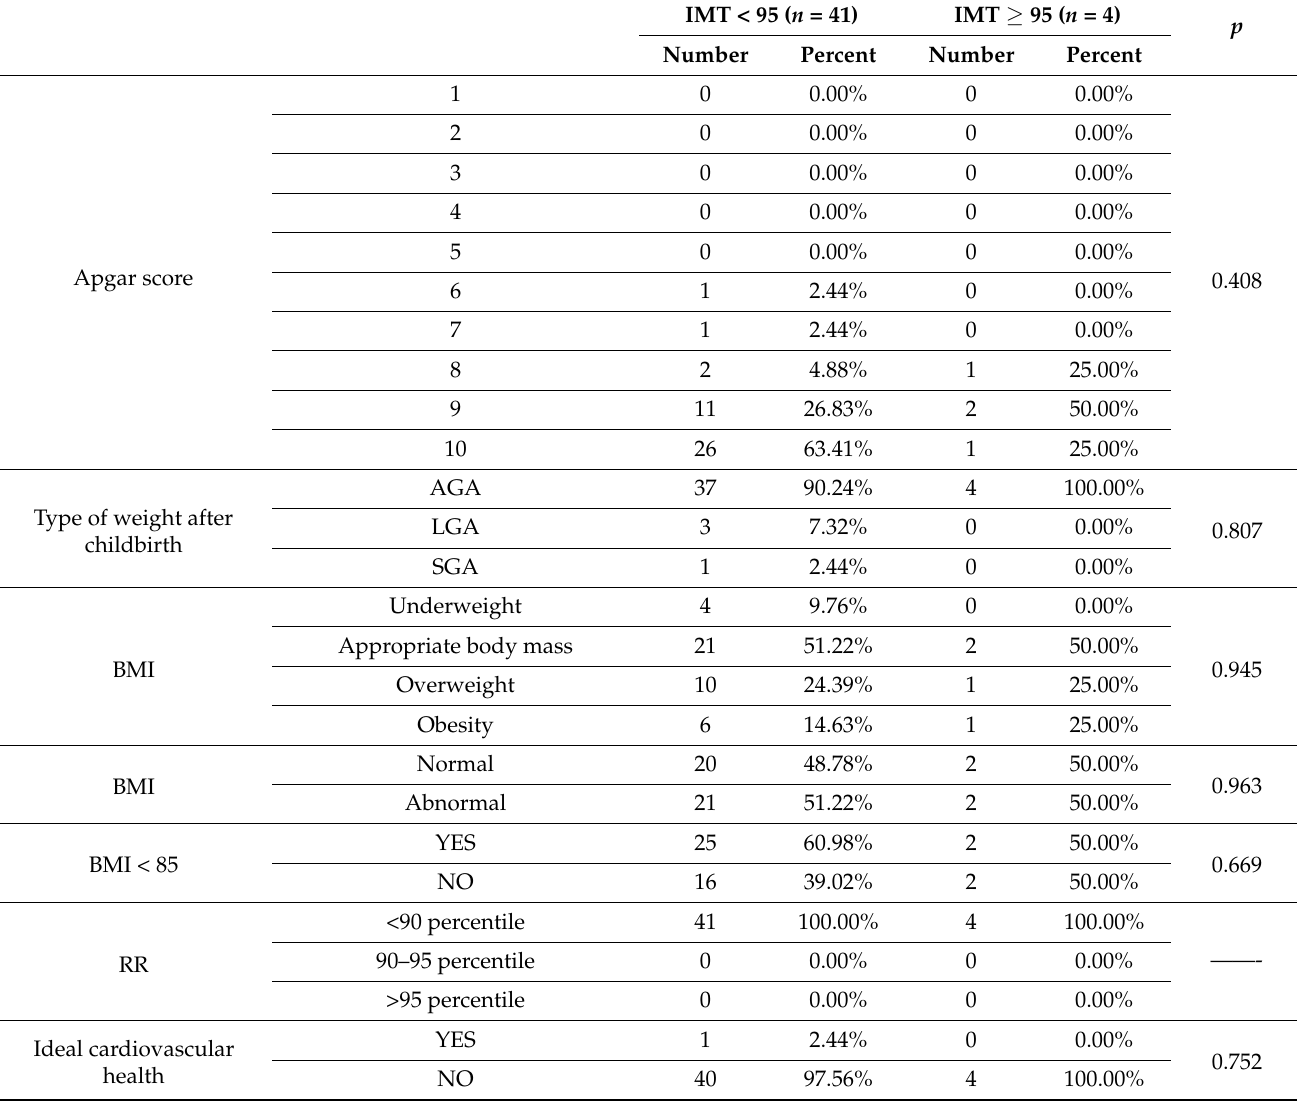
Table 3. Relationships between the intima media complex and other parameters in the study